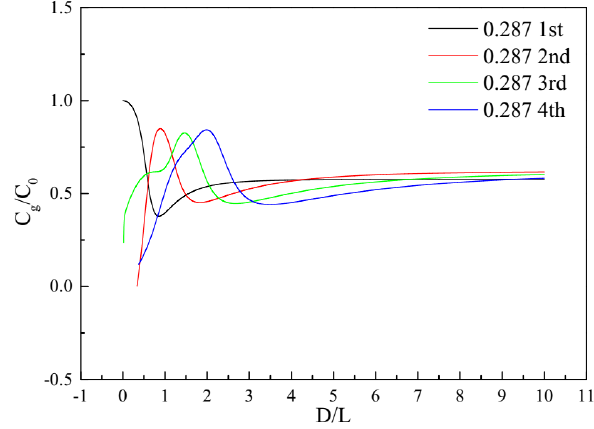
Figure 4. The first to fourth order group velocity curves of Poisson’s ratio of 0.287 .